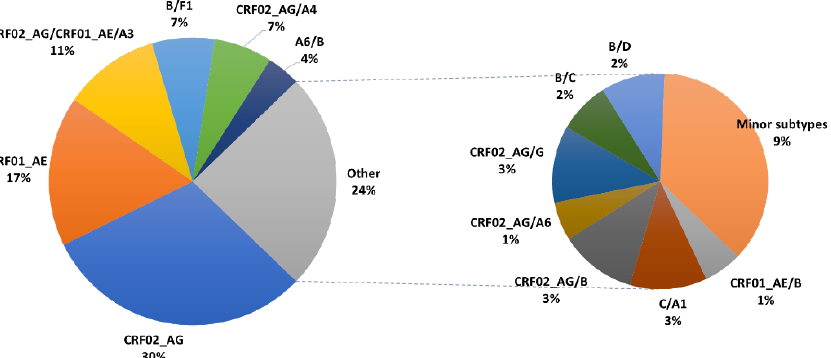
Figure 3. Proportion of HIV-1 CRFs and URFs in Israel, 2010–2018. Here, the large pie shows the distribution of the most prevalent ones, while the small one shows the distribution of less common forms of recombinants.